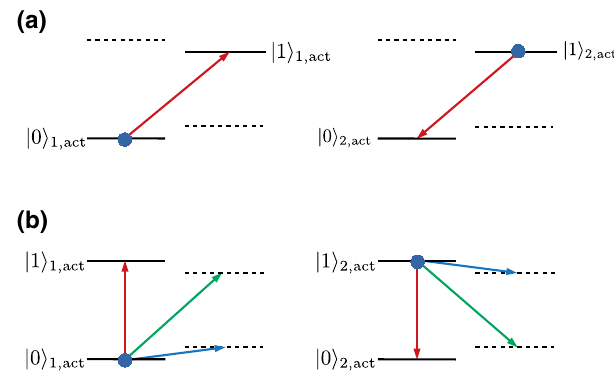
FIG. 5. Two possible active qubit choices that are found by minimizing the number of resonant channels and maximizing the lifetime of the active qubits: (a) the electronuclear qubit and (b) the electronic qubit. We use here the same level struc- ture as for the excited doublet in Fig. 3, with the indices 1 and 2 labeling the two ions on which the CNOT gate acts. The red arrows denote the electronuclear and electronic “spin flip-flop” matrix elements for (a) and (b), respectively. Such a simultane- ous swap of both RE qubits is exactly resonant. The blue and green arrows in (b) denote the nuclear and electronuclear flip- flops, respectively, which are nearly resonant up to the nuclear Zeeman energy. These processes limit the fidelity of the CNOT gate in the most favorable case of active qubits with g ⊥ = 0, for which the electronic qubit (b) minimizes the gate error. In most host materials g ⊥ is nonzero and the electronuclear qubit (a) should be